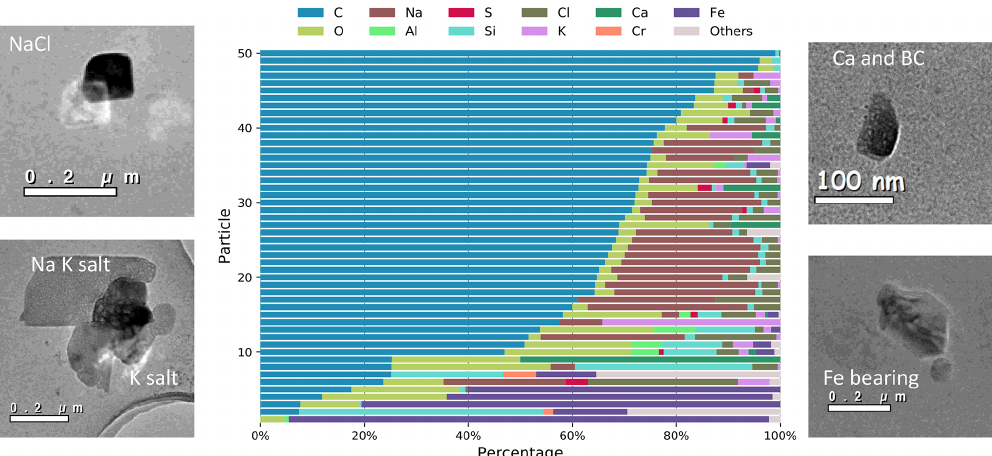
Figure 3. Elemental composition (mass percentage) and representative microphysical images of particles from TEM-EDX analysis for the collected sample (sampled on 24 August 2017 09:43–09:49UTC, at 319.4m) near